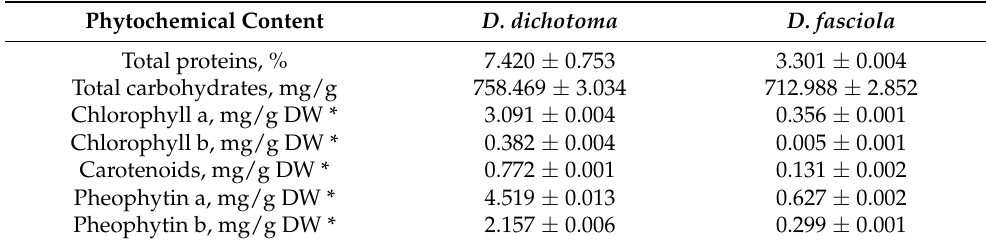
Table 1. Total protein, carbohydrate, and chlorophyll content in two brown seaweeds from the Dictyota family. All results are expressed as